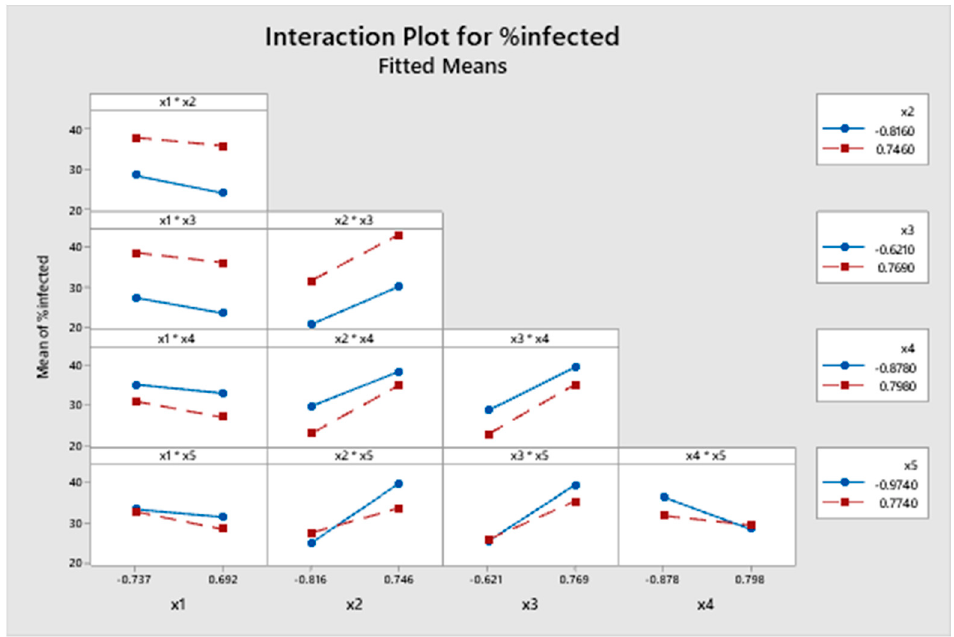
Figure 5. Interaction Plot for %infected.